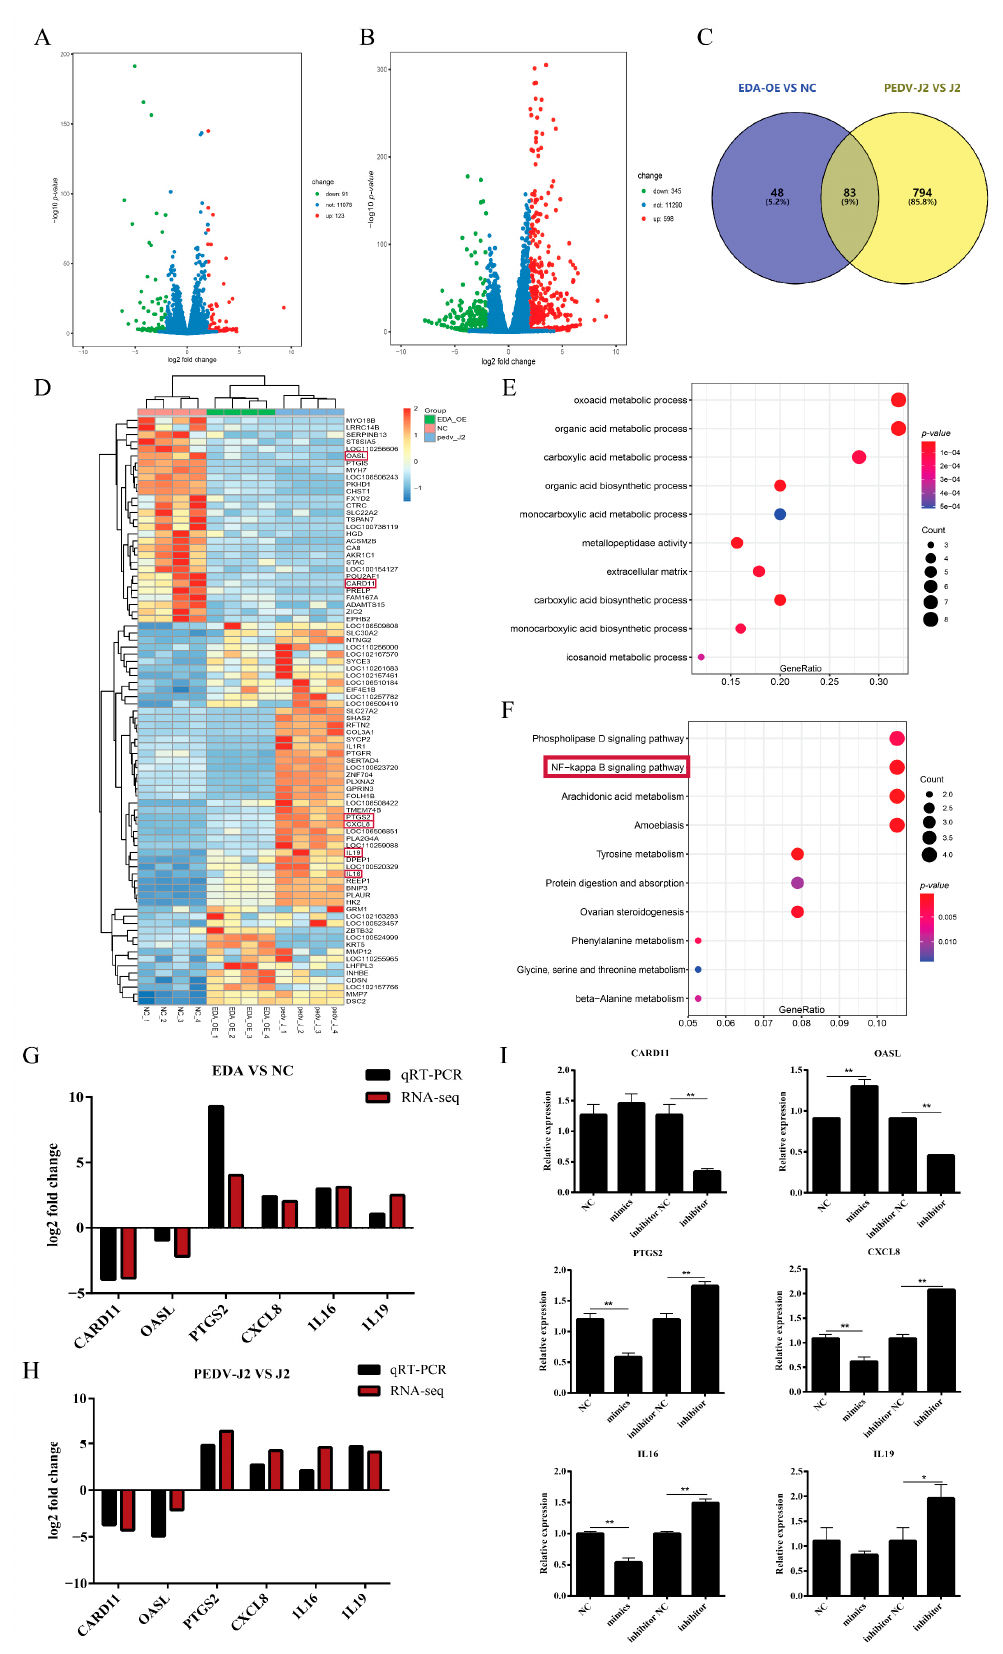
Figure 4. Mechanism of downstream regulation of the EDA gene. ( A ) Volcano plot of differential genes between the